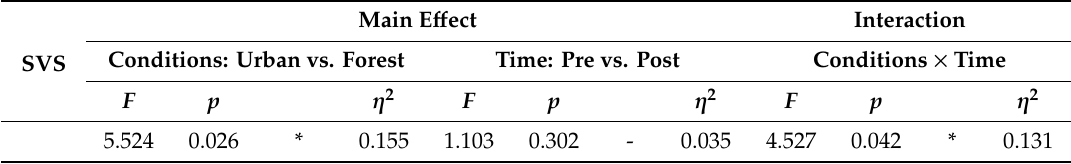
Table 10. Results of multiple comparisons of SVS scores for urban street versus forest environments, as well as before and after environmental exposure. Urban Forest Pre Post Pre Post Average S.D. Average Pre Post Forest Urban Forest